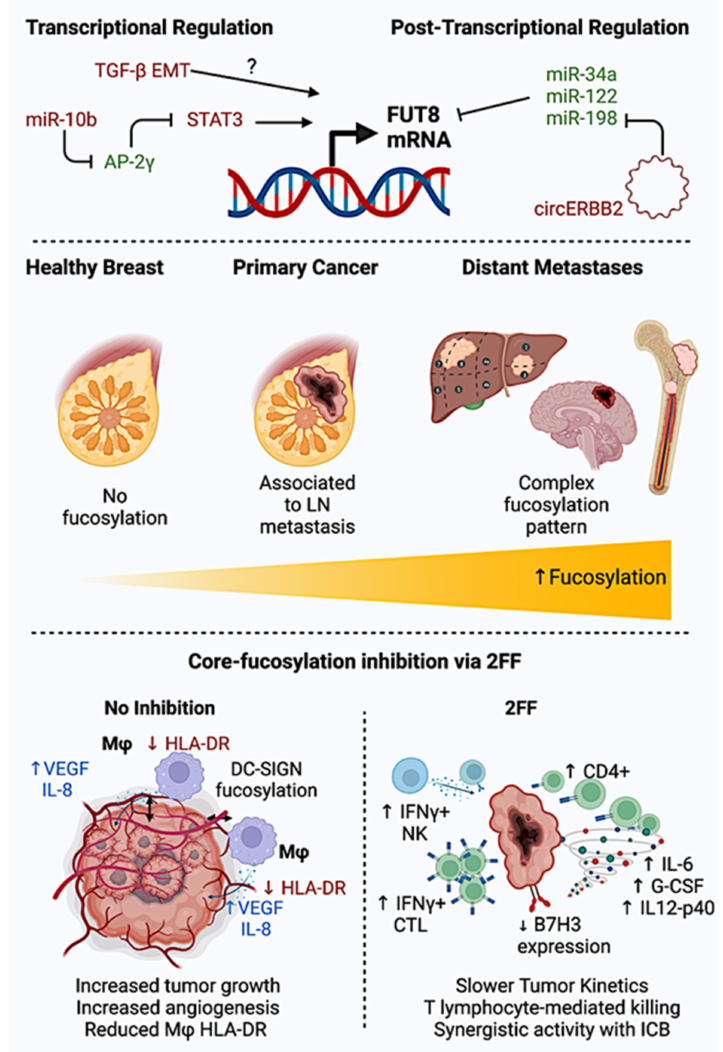
Figure 2. Fucosylation in Breast Cancer (BC): Biomarker and Therapeutic Vulnerability. Role of Fucosylation in BC. Top: Transcriptional and post-transcriptional regulation of FUT8 expression in BC (red: promoting FUT8 transcription; green: inhibiting FUT8 transcription/translation). Mid- dle: Fucosylation as a biomarker across disease stages, showing no expression in healthy mam- mary glands, intermediate expression in locally advanced disease (associated with lymph node metastasis), and highest expression in metastatic disease. Bottom: Pharmacological inhibition in pre-clinical tumor models via 2FF induces CTL-/NK-mediated tumor killing, and synergistic activ- ity with immune checkpoint inhibitors (i.e., anti-PDL1 mAb), ultimately reducing tumor